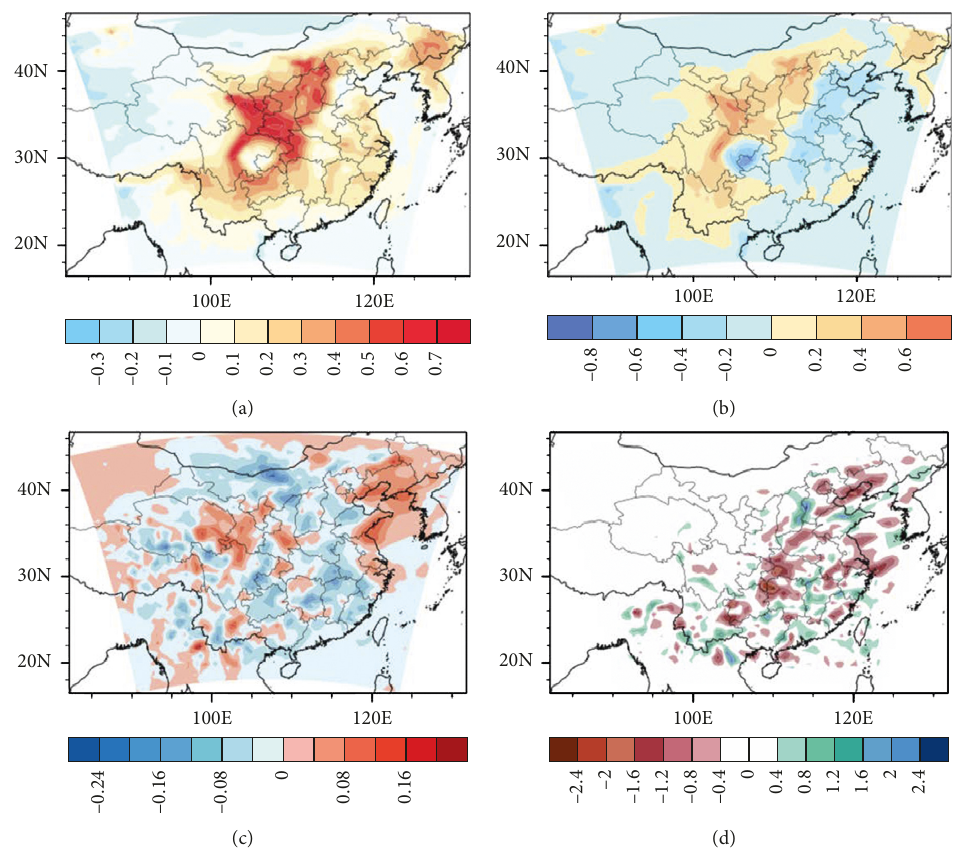
Figure 4: Differences between the climate effects of BC aerosols simulated by the two parameterization schemes. (a) All-sky top-of- atmosphere radiative forcing (TRF; W/m 2 ). (b) Clear-sky TRF (W/m 2 ). (c) Temperature (K). (d) Precipitation